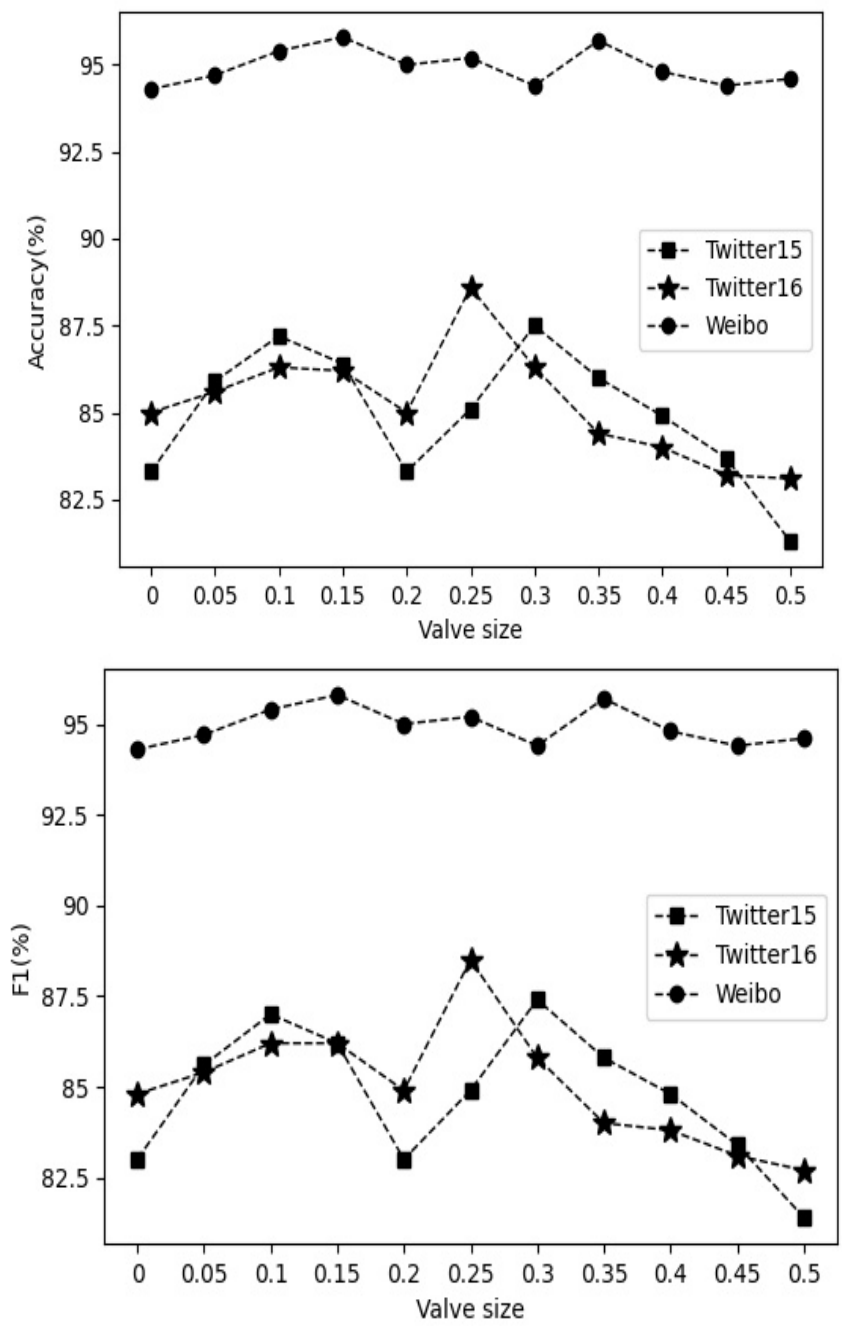
Figure 4. Influence of different valve thresholds on model performance.